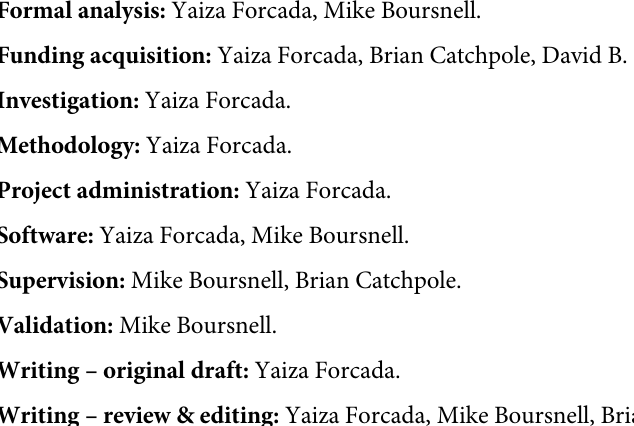
S1 Table. Updated map file according to FelCat9